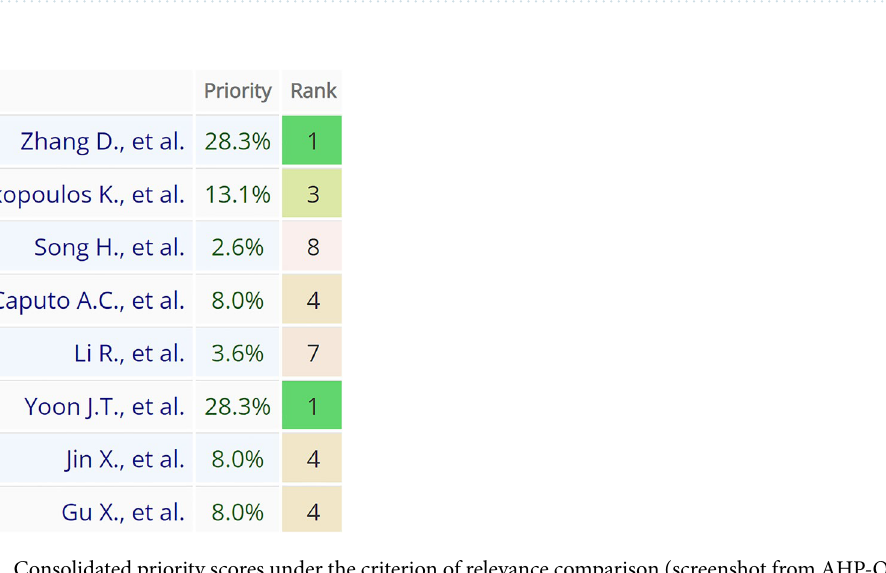
Figure 5. Decision matrix for the criterion of relevance (screenshot from AHP-OS software). The row no. 1 and the column no. 1 correspond with Fig. 4 comparison results.